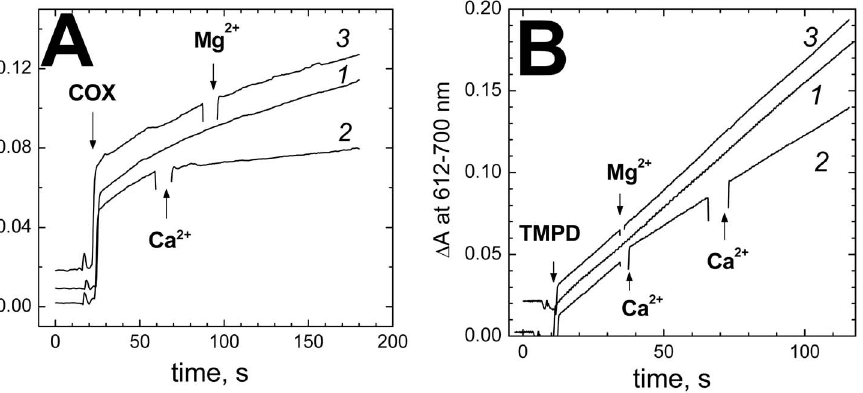
Figure 3. Ca 2 + inhibits aerobic oxidation of artificial electron donors by COX. ( A ) Oxidation of ferrocyanide. 0.2 mM ferrocyanide in the basic buffer pH 8.2, supplemented with 30 m g/ml of poly-L-lysine to stimulate reaction of COX with ferrocyanide anion [38]. Reaction is initiated by addition of 0.4 m M bovine COX and accumulation of ferricyanide is followed at 420 nm vs the 500 nm reference. Trace 1 , control recording with no other additions; trace 2 , 200 m M CaCl 2 added where indicated; trace 3 , 400 m M MgSO 4 added instead of CaCl 2 . The initial upward jump of the traces is due to absorption of the added COX. ( B ) Oxidation of N,N,N’,N’ – tetrametyl- p -phenylenediamine. 0.15 m M bovine COX in the basic buffer. Where indicated, 0.1 mM reduced TMPD is added, and its oxidation to Wurster’s Blue is followed spectrophotometrically at 612 nm vs the 700 nm reference. Trace 1 , control recording with no additions; trace 2, 200 m M CaCl 2 added where indicated, note that the second addition does not induce any further inhibition; trace 3 , 200 m M Mg 2 + added where indicated. The kinetics curves in the panels A and B are displaced arbitrarily on the ordinate axis for clarity.